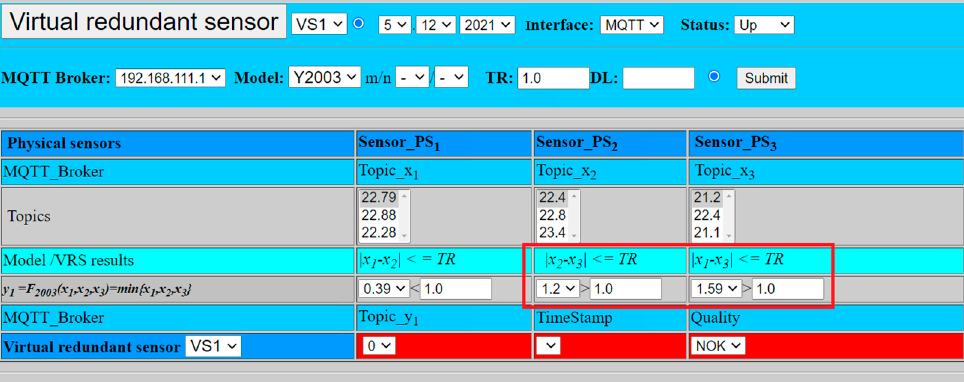
Figure 15. Virtual sensor with fusion function 𝐹 (cid:2870)(cid:2925)(cid:2925)(cid:2871) and negative result.